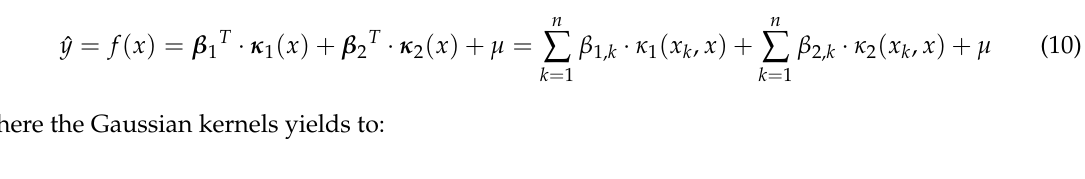
Figure 4. Using double σ to enhance the quality of curve fitting, ( a ) SVR algorithm with single σ ; ( b ) SVR algorithm with double σ .